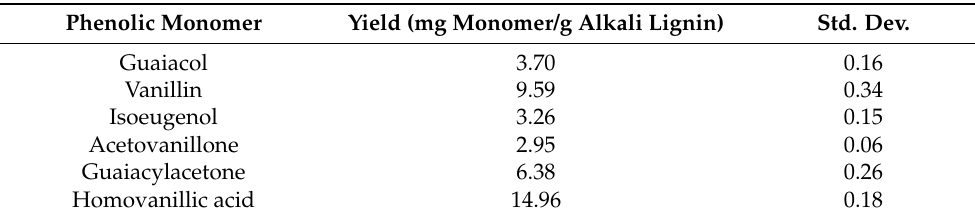
Table 5. Yield phenolic monomers in the presence of Ni-graphene catalyst at 240 ◦ C with standard deviation of triplicate